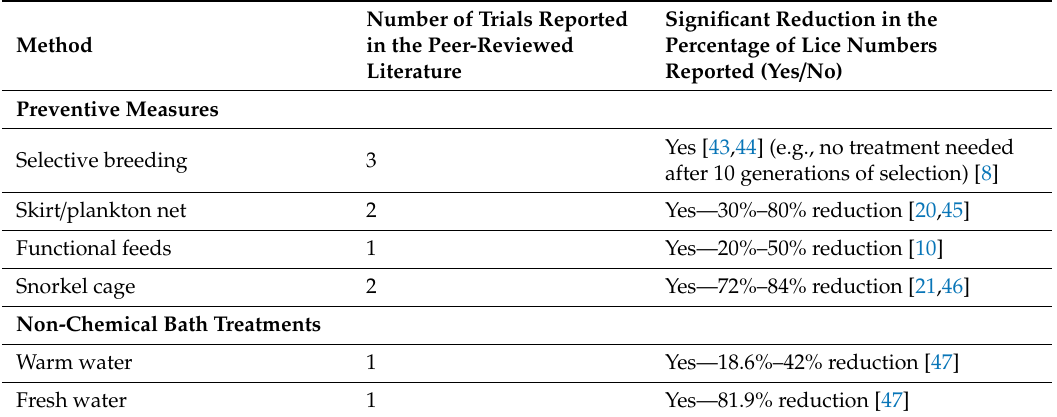
Table 4. Non-chemical treatments and preventive measures used against Lepeophtheirus salmonis